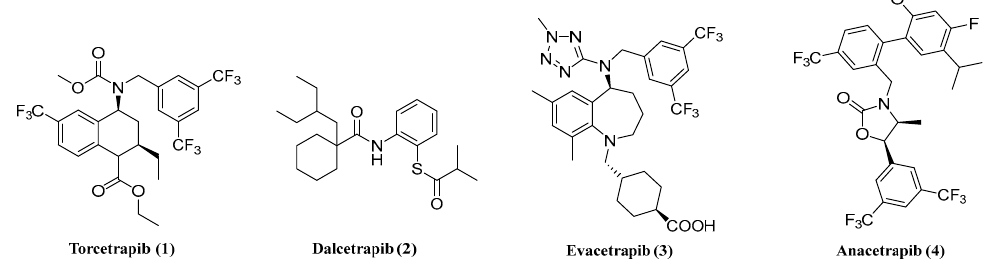
Figure 1. Representative cholesteryl ester transfer protein (CETP) inhibitors.